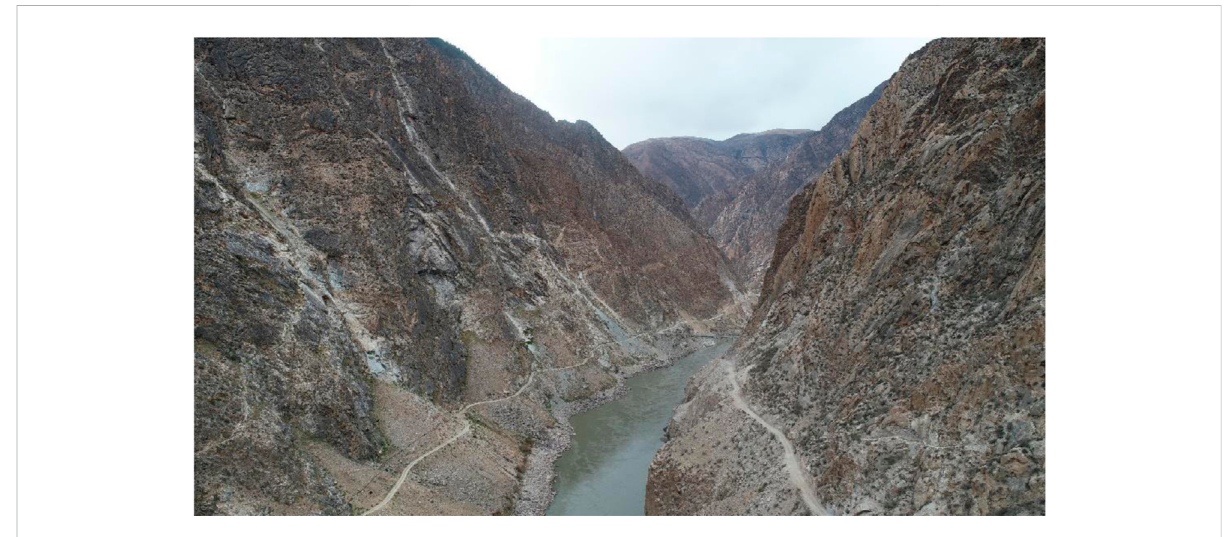
FIGURE 1 Steep mountain slopes in alpine